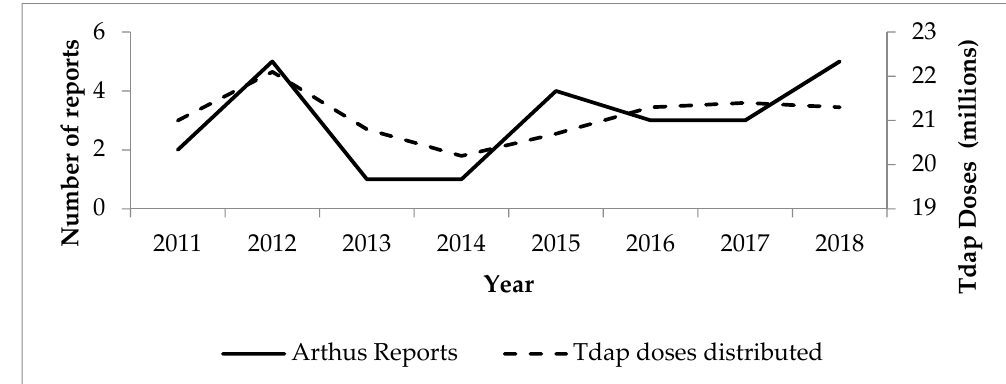
Figure 1. Trends in reporting of Arthus reaction following Tdap vaccines in the Vaccine Adverse Events